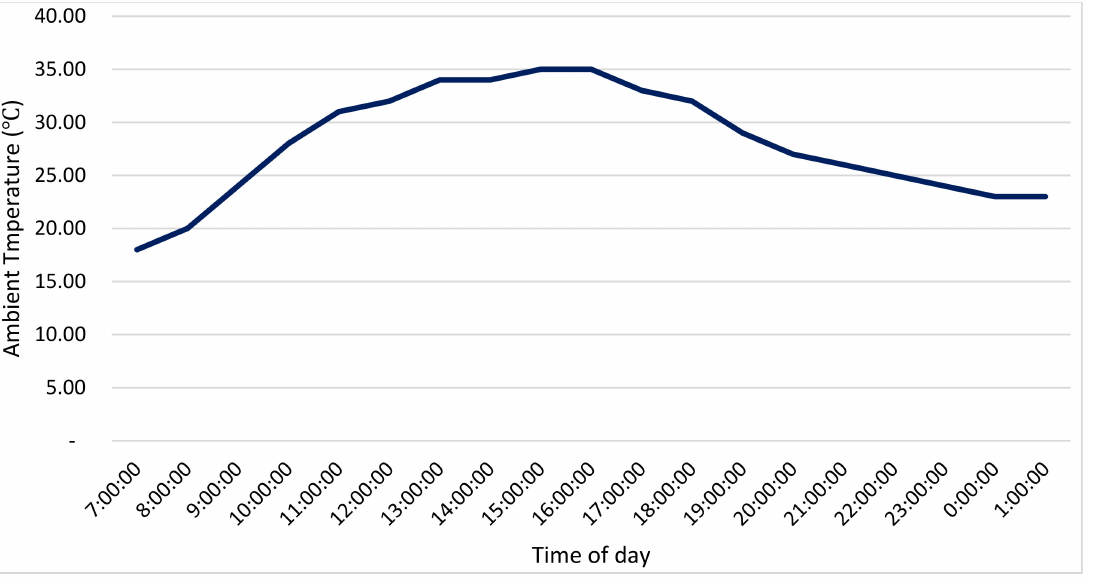
Figure 6. Hourly AT of the Northern